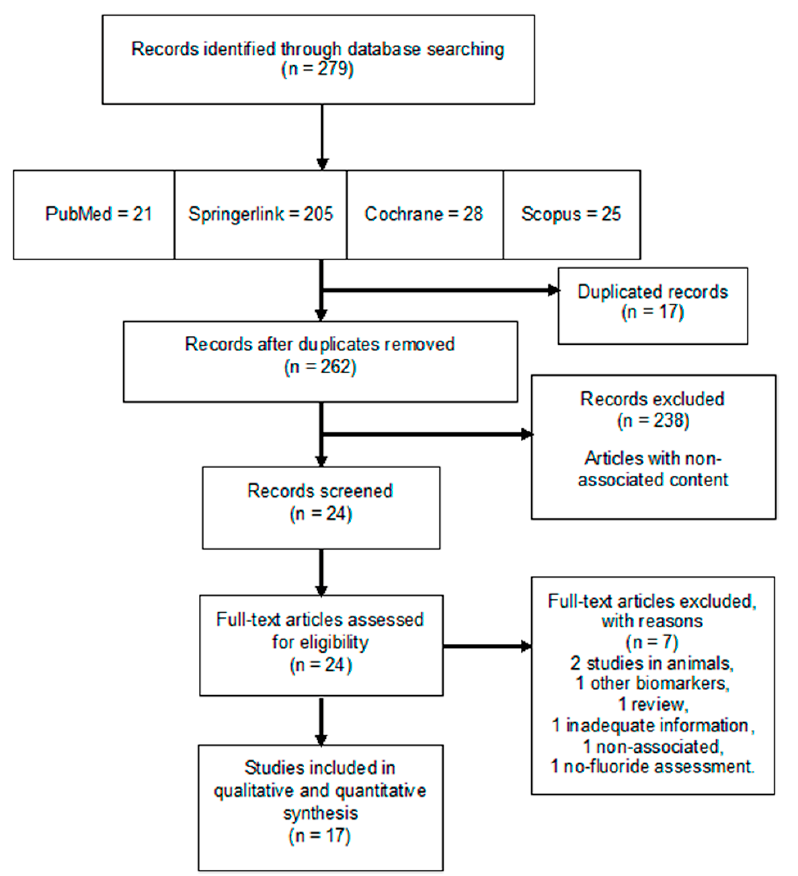
Figure 1. PRISMA flow chart for the systematic review. From the 279 articles found in the four databases included in the search, 17 studies were selected in this study for their analysis.